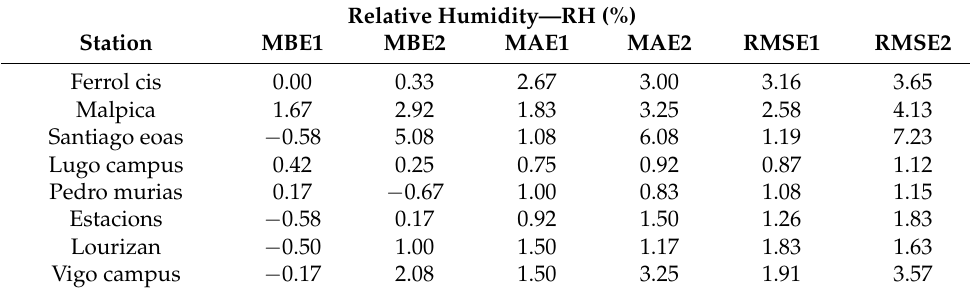
Table A2. RH error statistics for the 8 stations.